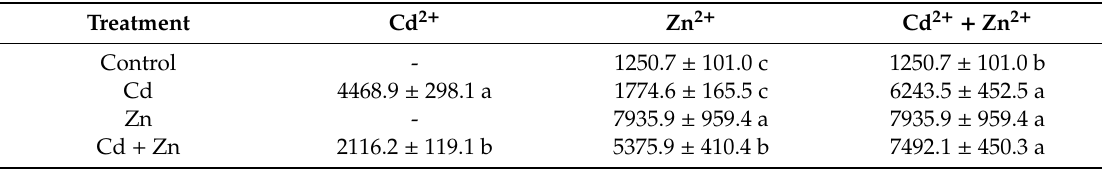
Table 2. The concentrations and summations of Cd 2 + and Zn 2 + in the roots of tall fescue under di ff erent